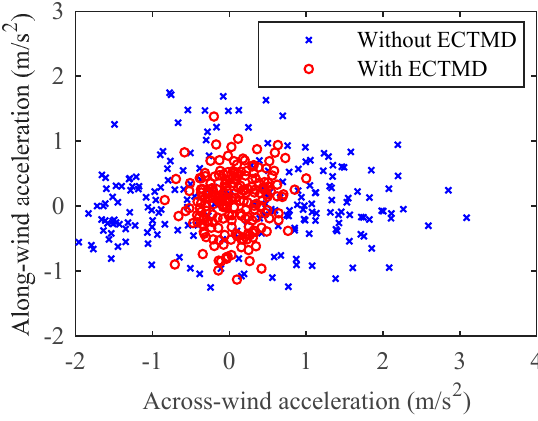
Figure 16. Across-wind vibration versus along-wind vibration.